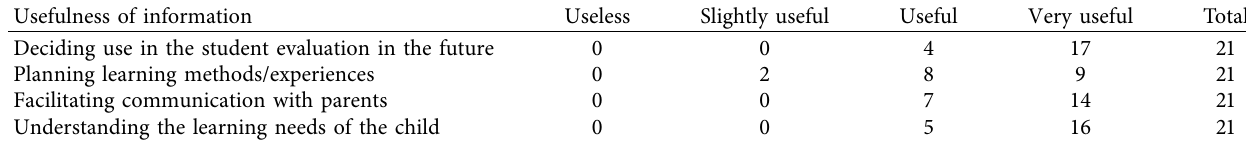
Table 2: Usefulness of the information obtained by the ELORS scale in terms of the teachers.